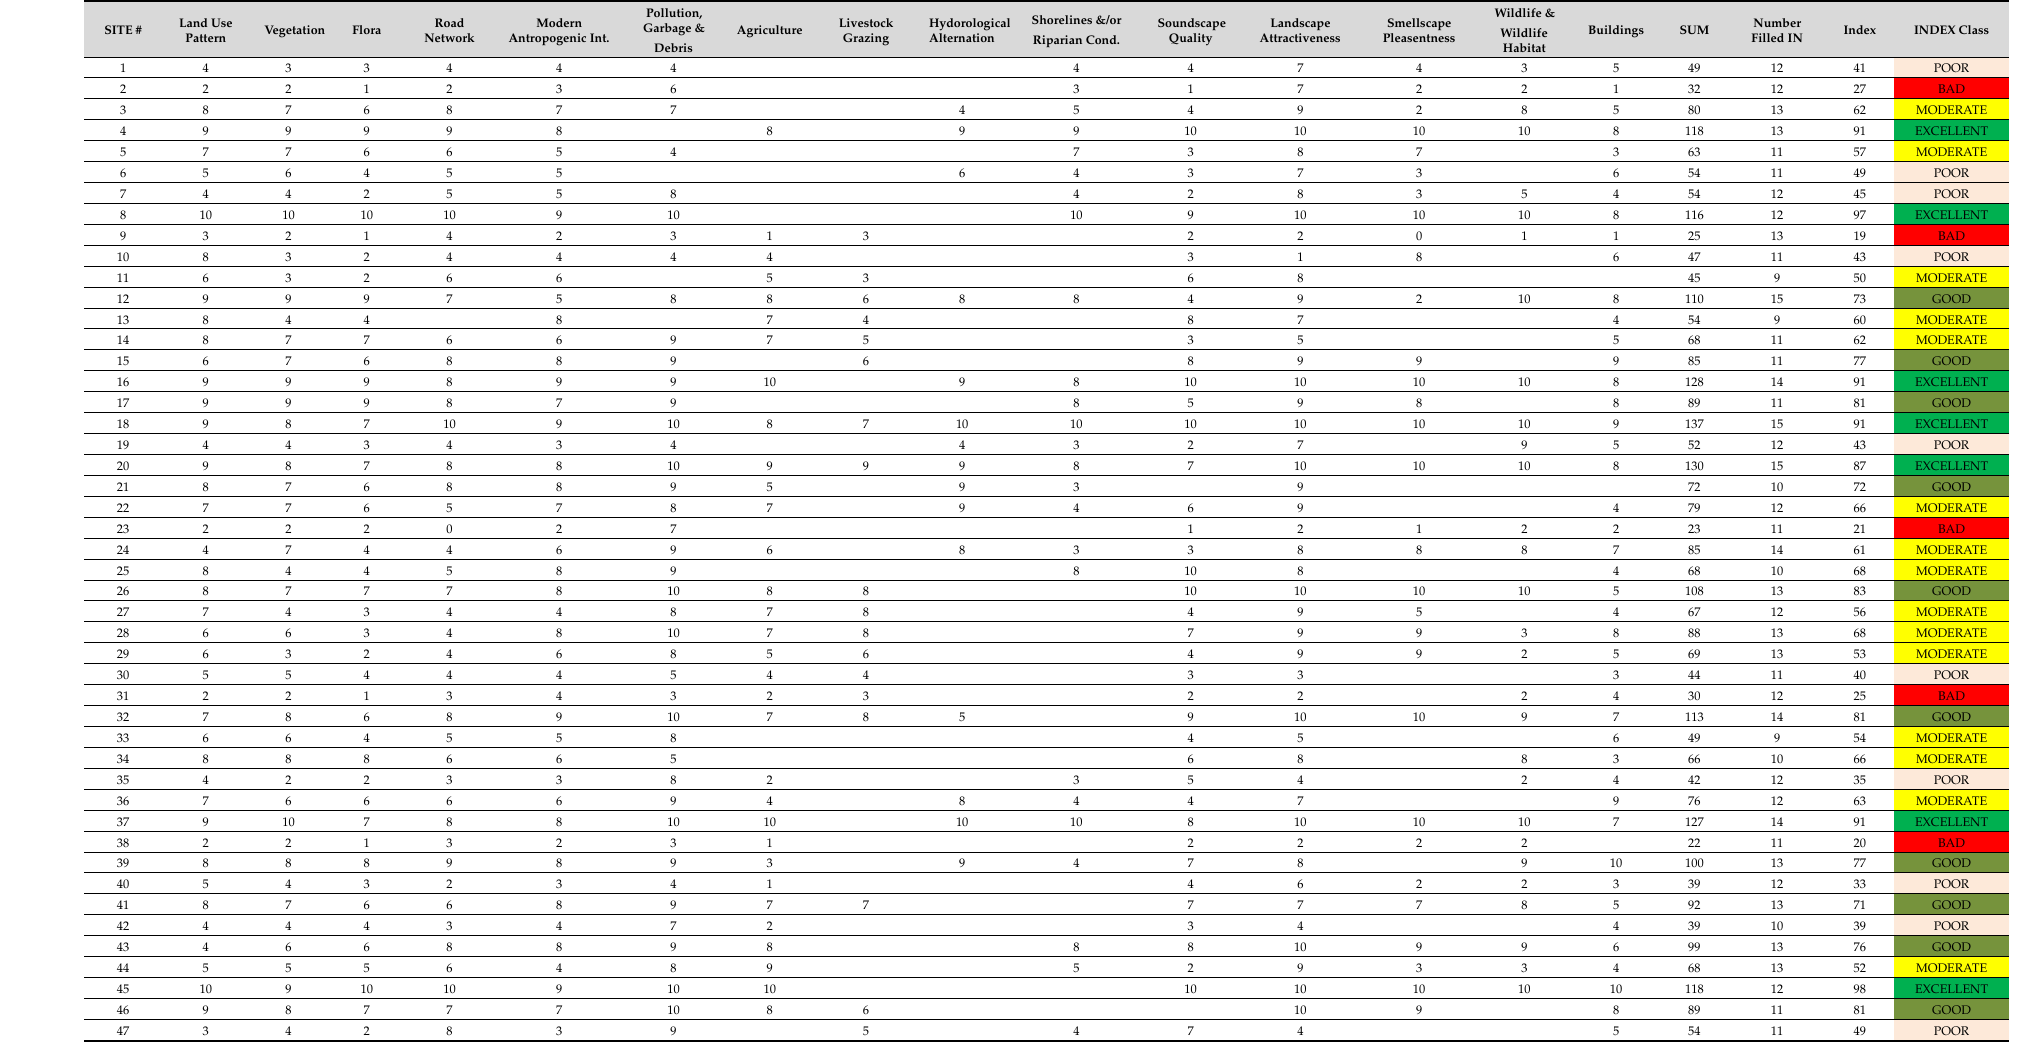
Table A2. Site dataset with all scored metrics and LAP conservation index results; site numbers as in Table